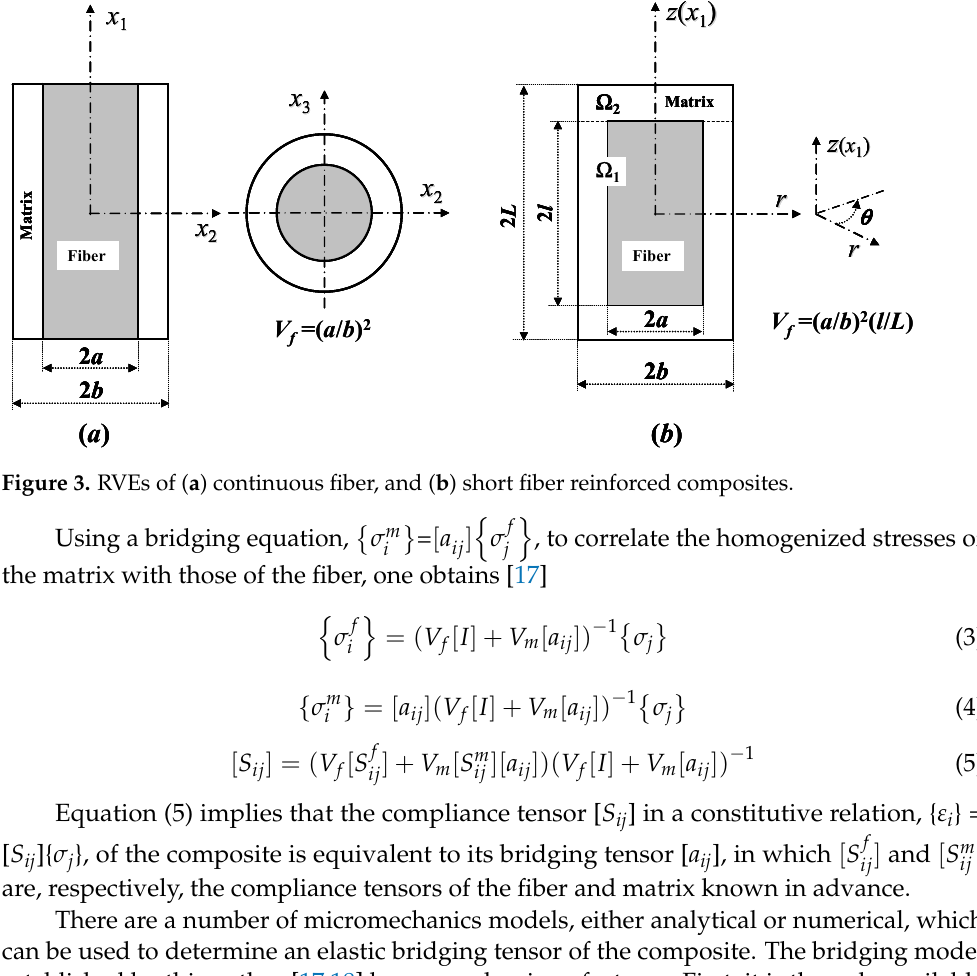
be calculated from Equations (3) and (4) in either the 2D or the 3D formulae, with a 3D stress vector given by, e.g., { σ j } = { σ 11 , σ 22 ,0,0,0, σ 12 } T . If the resulting internal stresses from the two sets of formulae are exactly the same, the constitutive theory is consistent in the internal stress calculation. A necessary and sufficient condition for a constitutive theory to be consistent is that its bridging tensor is upper-triangular. Only the bridging tensor of the bridging model is always upper-triangular, whereas all of the others known yet are not [16]. For a non-consistent theory, its 3D formulae have to be used to calculate the internal stresses of the fiber and matrix more accurately. The calculation amount is at least one order higher than that by using the 2D ones. Second, it is a unified analytical constitutive model for a composite reinforced with either continuous fibers, or short fibers, or particles, no matter the constituent, e.g., matrix, undergoes an elastic or plastic deformation [17–20]. Third, it is overall more accurate than most other micromechanics including numerical models